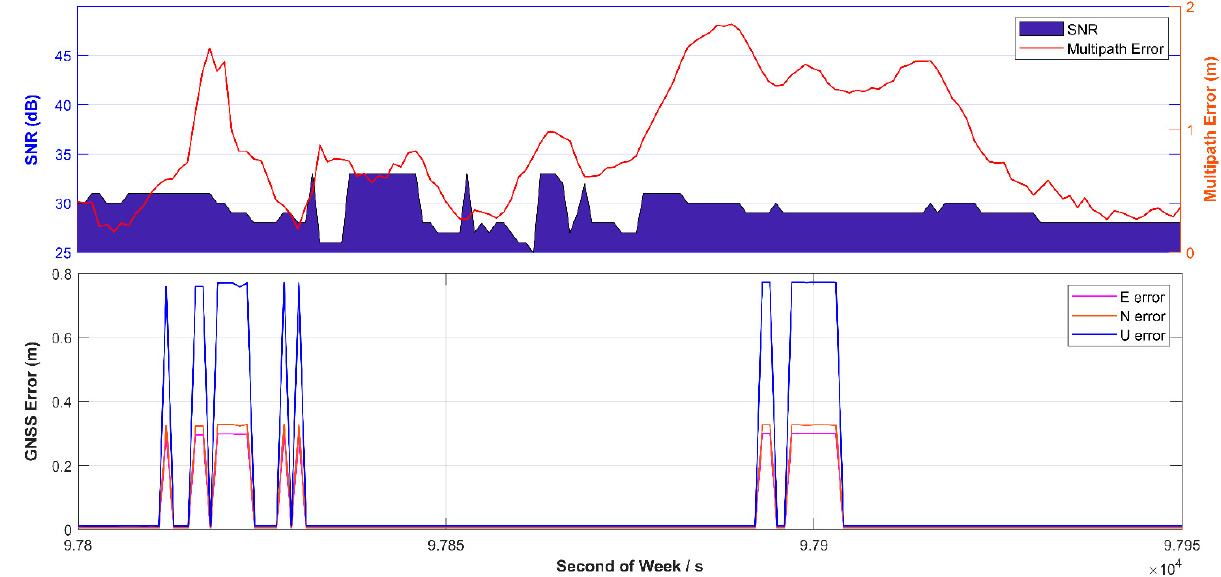
Figure 11. Correlation of SNR, multipath error, and GNSS standard deviation.